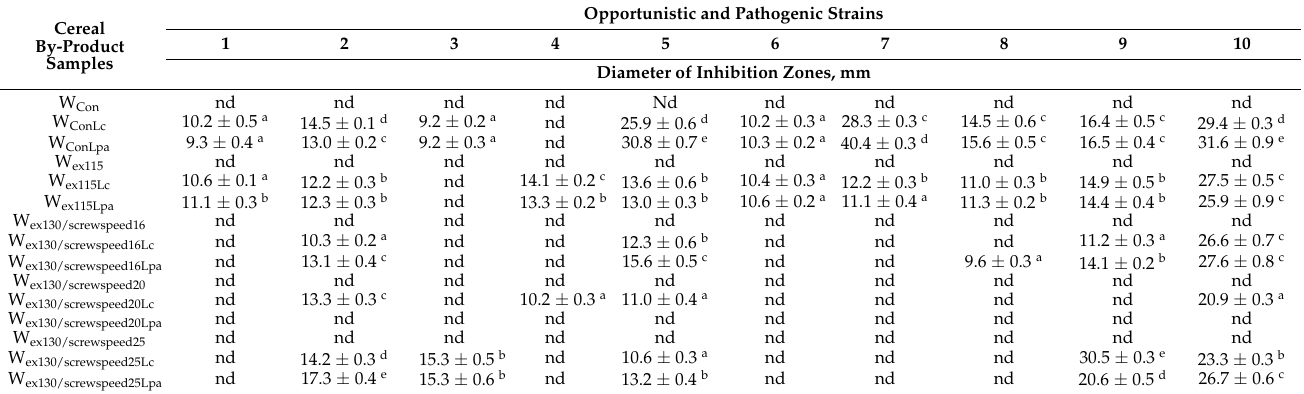
Table 2. Antimicrobial properties of extruded and non-treated wheat processing by-products, non- fermented and fermented with L. casei and L. paracasei strains.